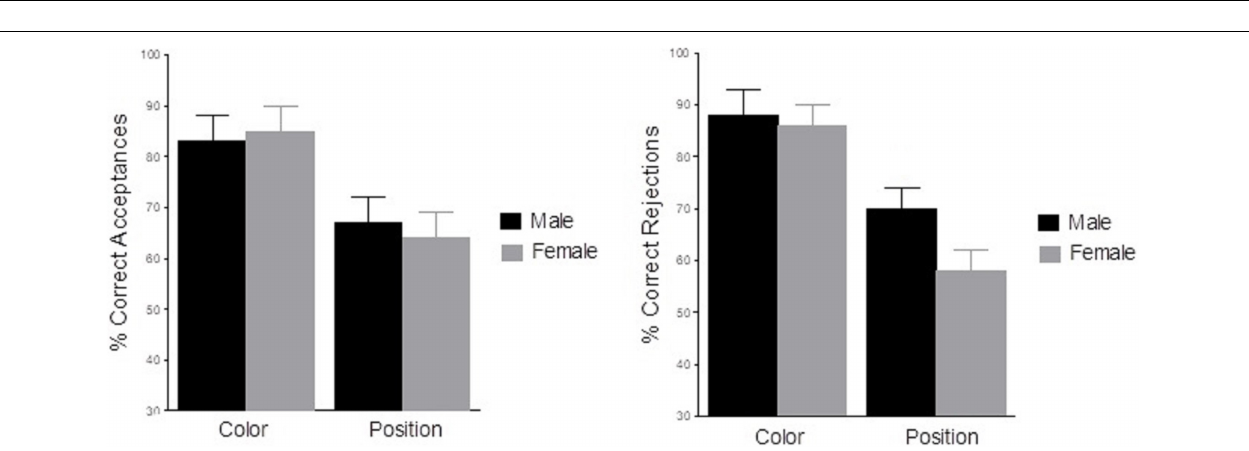
FIGURE 2 | Example of a trial sequence for the spatial recognition task. Depending on the Criteria, participants need to memorize different information of a Memory Image and subsequently answer about it in a Recognition Image.